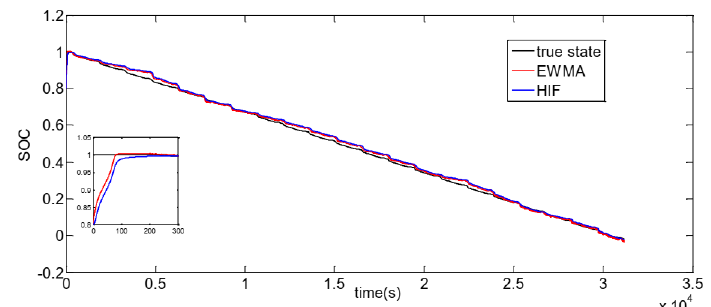
Figure 6. The estimated state curve of the two